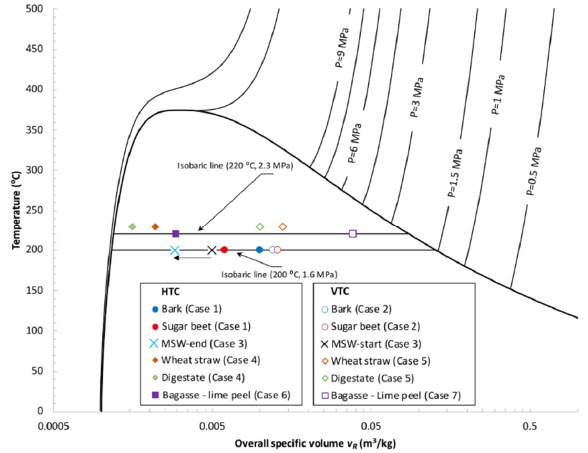
Figure 6. Comparison of the process conditions for the seven cases in the T – v diagram for water.